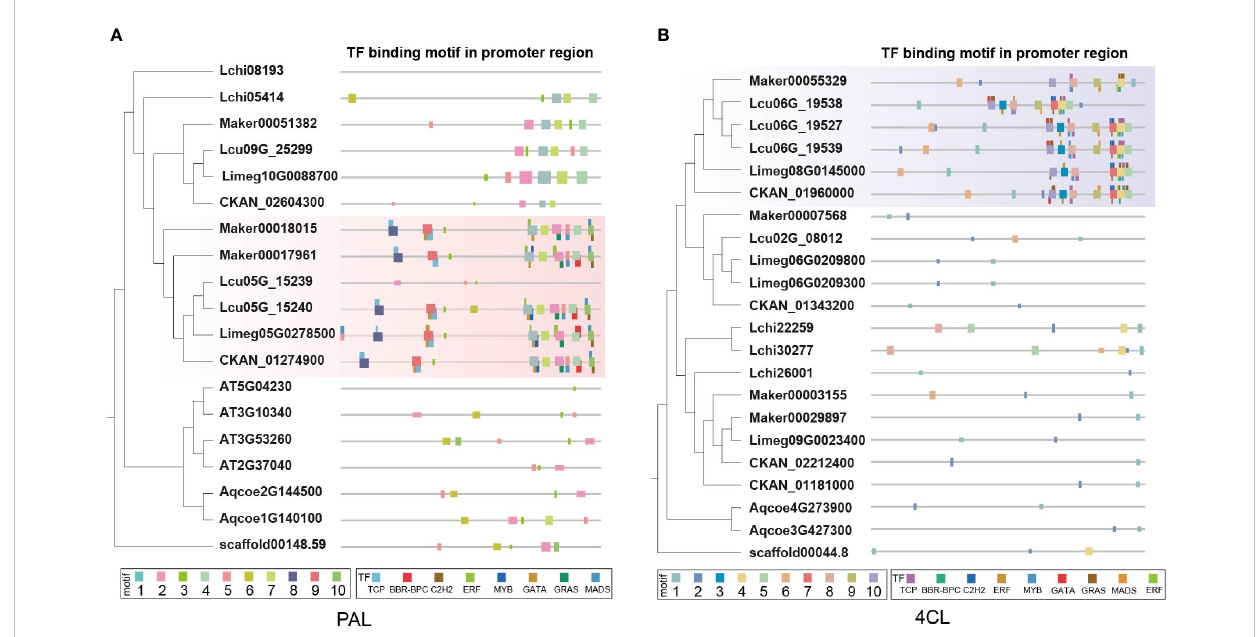
FIGURE 7 Characterization of PAL and 4CL genes in Lauraceae species. (A) Different panels represent of the phylogenetic tree of the PAL gene family (the left), the distribution of motifs in the promoter sequence and the predicated transcription factor binding sites (TFBS) (the right). Fat squares represent the motifs and thin ones the TFBSs. Red boxes highlight the promoter motifs uniquely found among the Lauraceae species. (B) Different panels represent of the phylogenetic tree of the 4CL gene family (the left), the distribution of motifs in the promoter sequence and the predicated transcription factor binding sites (TFBS) (the right). Fat squares represent the motifs and thin ones the TFBSs. Purple boxes highlight the promoter motifs uniquely found among the Lauraceae